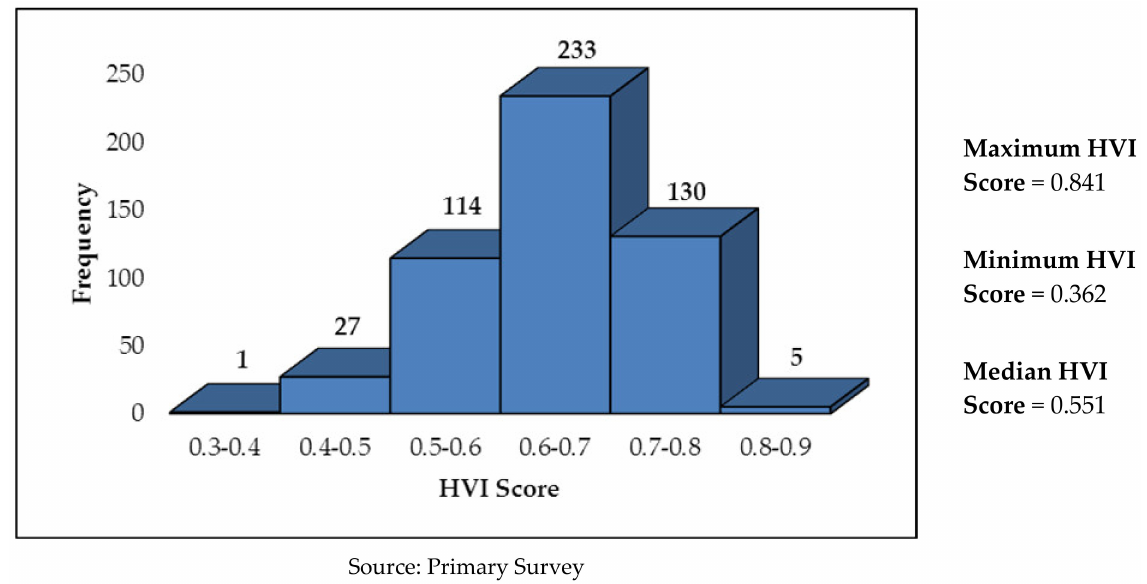
Figure 2. Pictorial Distribution of No. of Households by HVI Scores in